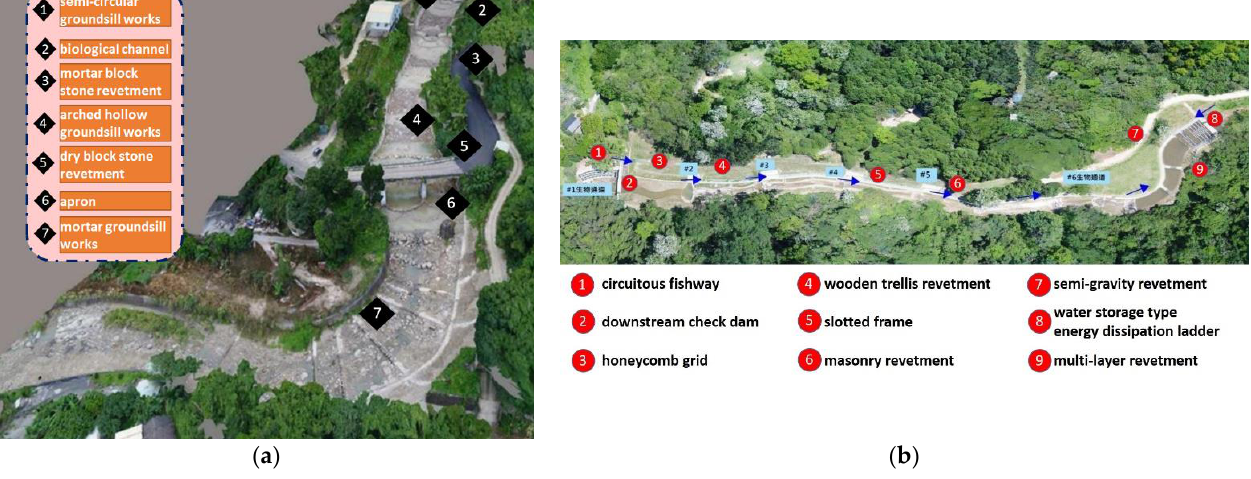
Figure 4. On-site investigation map: ( a ) Upstream Renovation Project of Toubiankeng Stream in Zhongpu; and ( b ) Renovation Project of Sijiaolin Stream (source: Soil and Water Conservation Bureau, Taiwan).